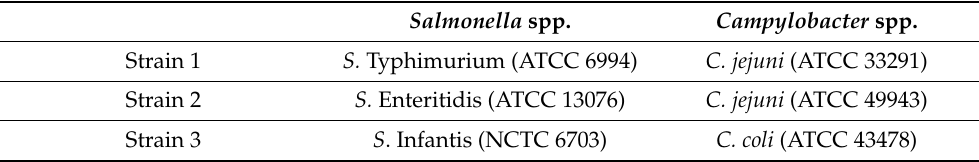
Table 1. List of the ATCC/NCTC Salmonella and Campylobacter strains used to contaminate the minced chicken meat